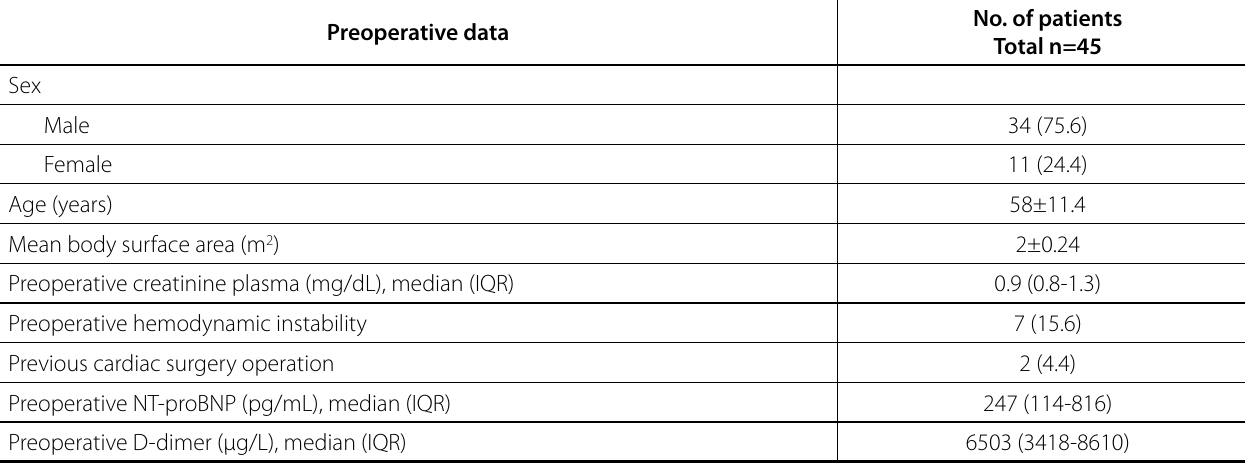
Table 1 . Baseline demographic and preoperative data.